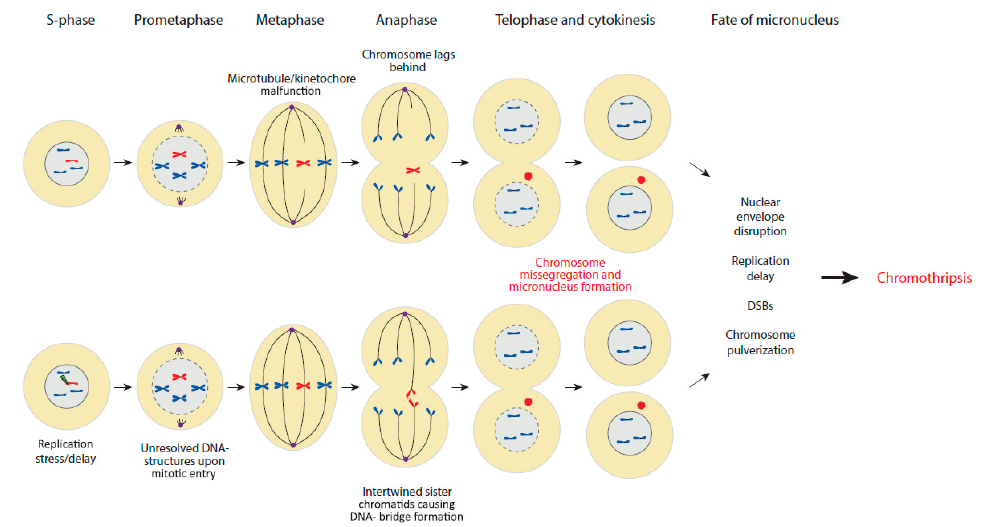
Figure 3. Micronucleus formation during mitotic cell division. A micronucleus can form when a chromosome lags in anaphase, resulting in missegregation and exclusion from the main nucleus upon cytokinesis. This can, for example, occur when the bipolar mitotic spindle fails to capture and segregate chromosomes because of microtubule / kinetochore malfunction (above) or when sister chromatids are entangled throughout mitosis by unresolved replication intermediates (arising in S-phase) that persist as DNA bridges (below) and prohibit faithful segregation. Chromosomes entrapped in micronuclei are accompanied by an unstable nuclear envelope and show delayed replication and susceptibility to DSBs and pulverization. These dramatic mitotic segregation errors are proposed to lead to the dramatic chromosomal rearrangements observed in chromothripsis.